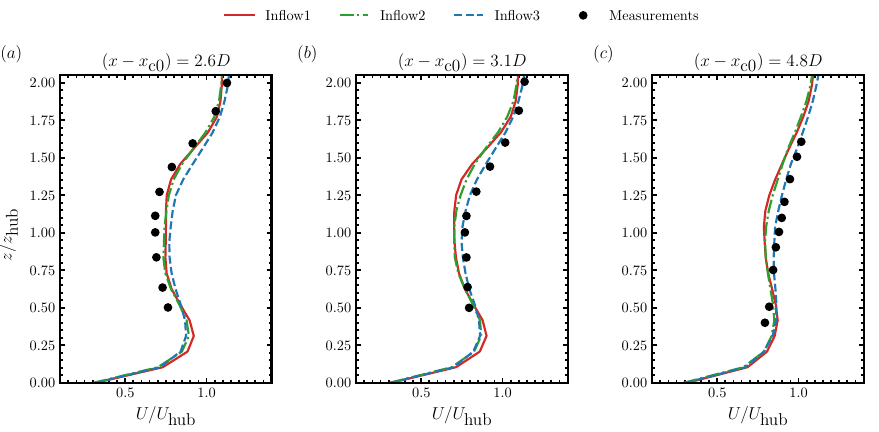
Figure A1. Comparison of the vertical profile of the mean streamwise velocity between the simula- tions and the field measurements at 2.6 D ( a ), 3.1 D ( b ), 4.8 D ( c ) turbine downwind